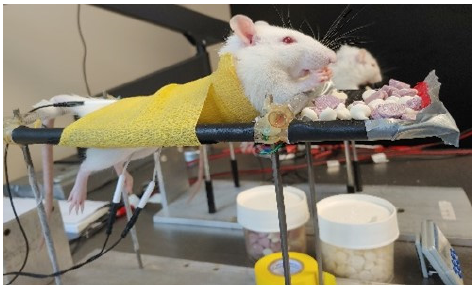
Figure 8. Transcutaneous spinal cord stimulation in the awake rodent.